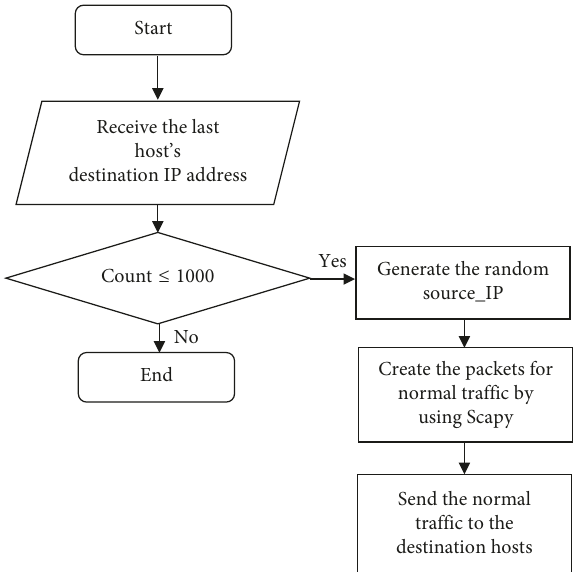
Figure 6: Step by step process of normal traffic